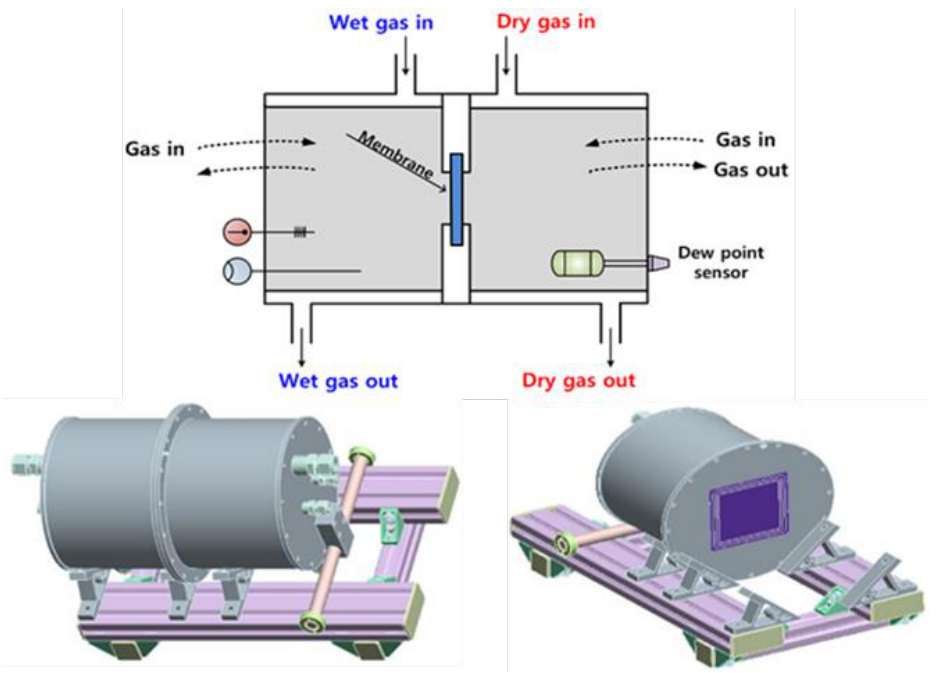
Figure 1. Design of the isothermal test jig.